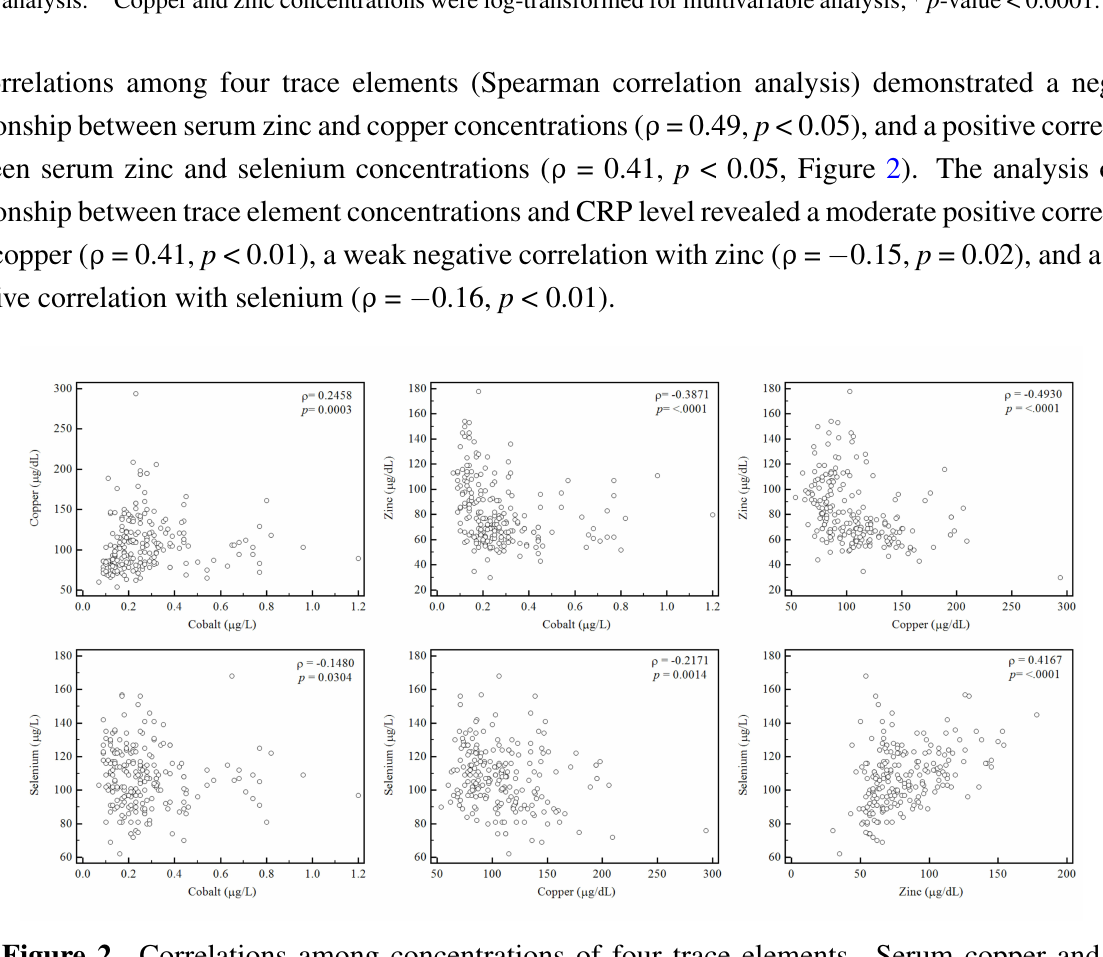
Figure 2. Correlations among concentrations of four trace elements. Serum copper